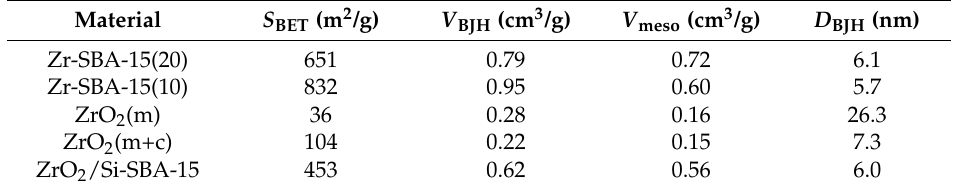
Table 1. Textural properties of the different Zr-based materials synthesized in this work.